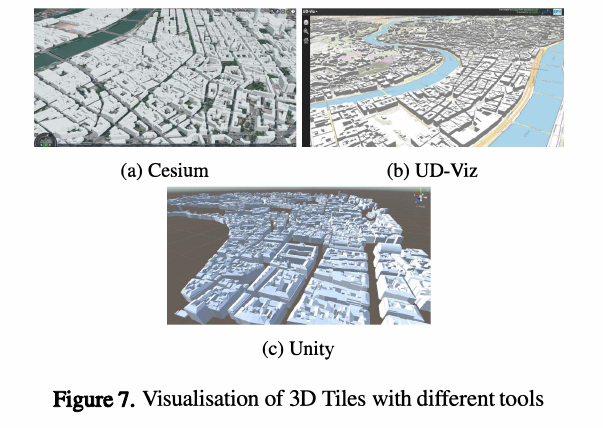
Figure 7. Visualisation o f 3D Tiles with different tools The different Tilers of Py3DTilers allow the creation of 3D Tiles representing different geospatial data layers: buildings, relief, rivers, roads, and bridges, as shown in figure 8. Buildings and data, with several levels of detail (figure 1 b ). Roads and rivers can be created from polygons or lines from GeoJSON